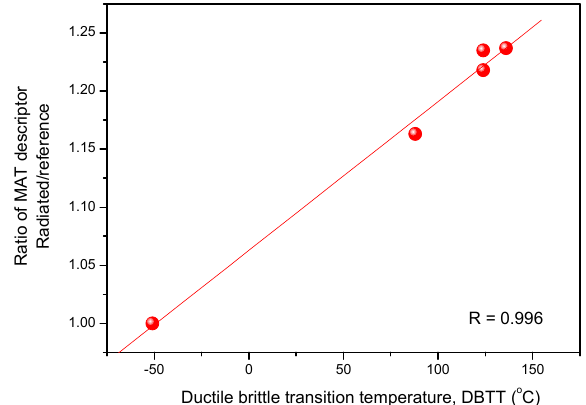
Figure 6. Ratio (normalized to the reference condition) of the optimally chosen MAT descriptor of selected irradiated and not-irradiated samples as a function of the transition temperature.